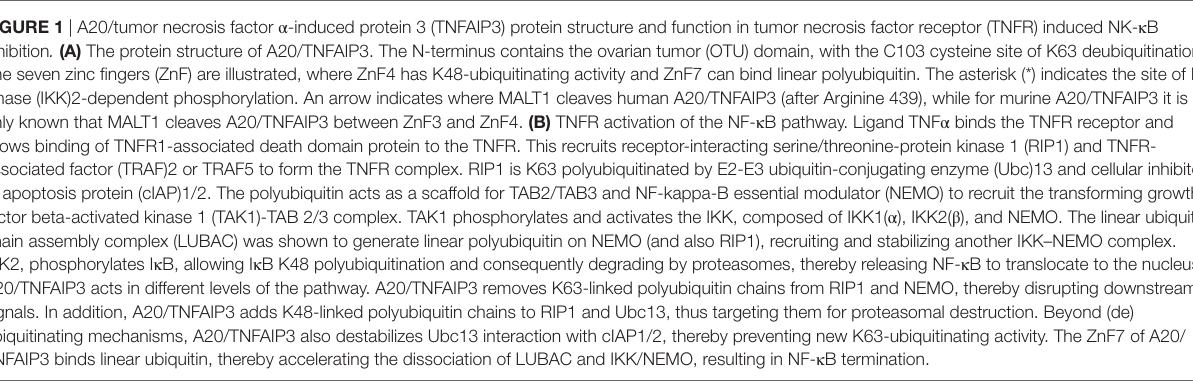
FiGURe 1 | A20/tumor necrosis factor α -induced protein 3 (TNFAIP3) protein structure and function in tumor necrosis factor receptor (TNFR) induced NK- κ B inhibition . (A) The protein structure of A20/TNFAIP3. The N-terminus contains the ovarian tumor (OTU) domain, with the C103 cysteine site of K63 deubiquitination. The seven zinc fingers (ZnF) are illustrated, where ZnF4 has K48-ubiquitinating activity and ZnF7 can bind linear polyubiquitin. The asterisk (*) indicates the site of I κ B kinase (IKK)2-dependent phosphorylation. An arrow indicates where MALT1 cleaves human A20/TNFAIP3 (after Arginine 439), while for murine A20/TNFAIP3 it